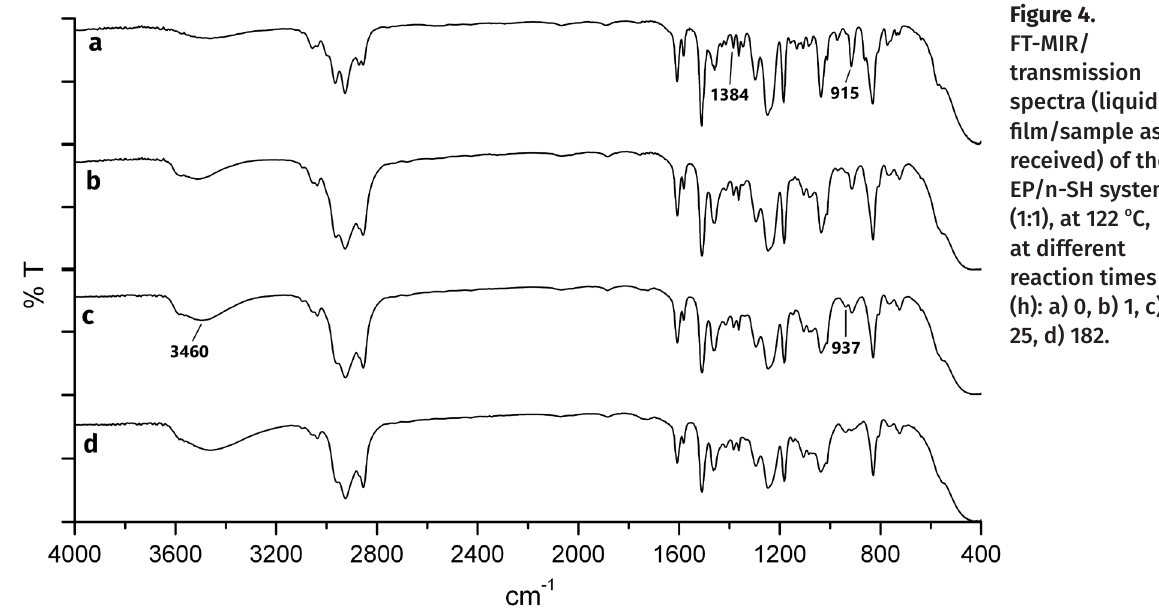
Table IV shows the FT-IR data of reaction times that displayed variations in epoxy ring consumption, the errors resulted from the NIRA/ transflectance analysis of the EP/n-SH/DETA (5:5:0.3), and the estimated percentage (%) of reaction. There is an increasing consumption of the epoxide rings. After 10 minutes 45% reacted, and after 24 hours (1440 min) almost 100% reacted. An increasing relative deviation (%) is observed during the reaction period due to the decrease in intensity of the analytical band which almost disappears because of the consumption of the epoxide groups. The methodology error of 4% is quite satisfactory considering the analysis conditions.